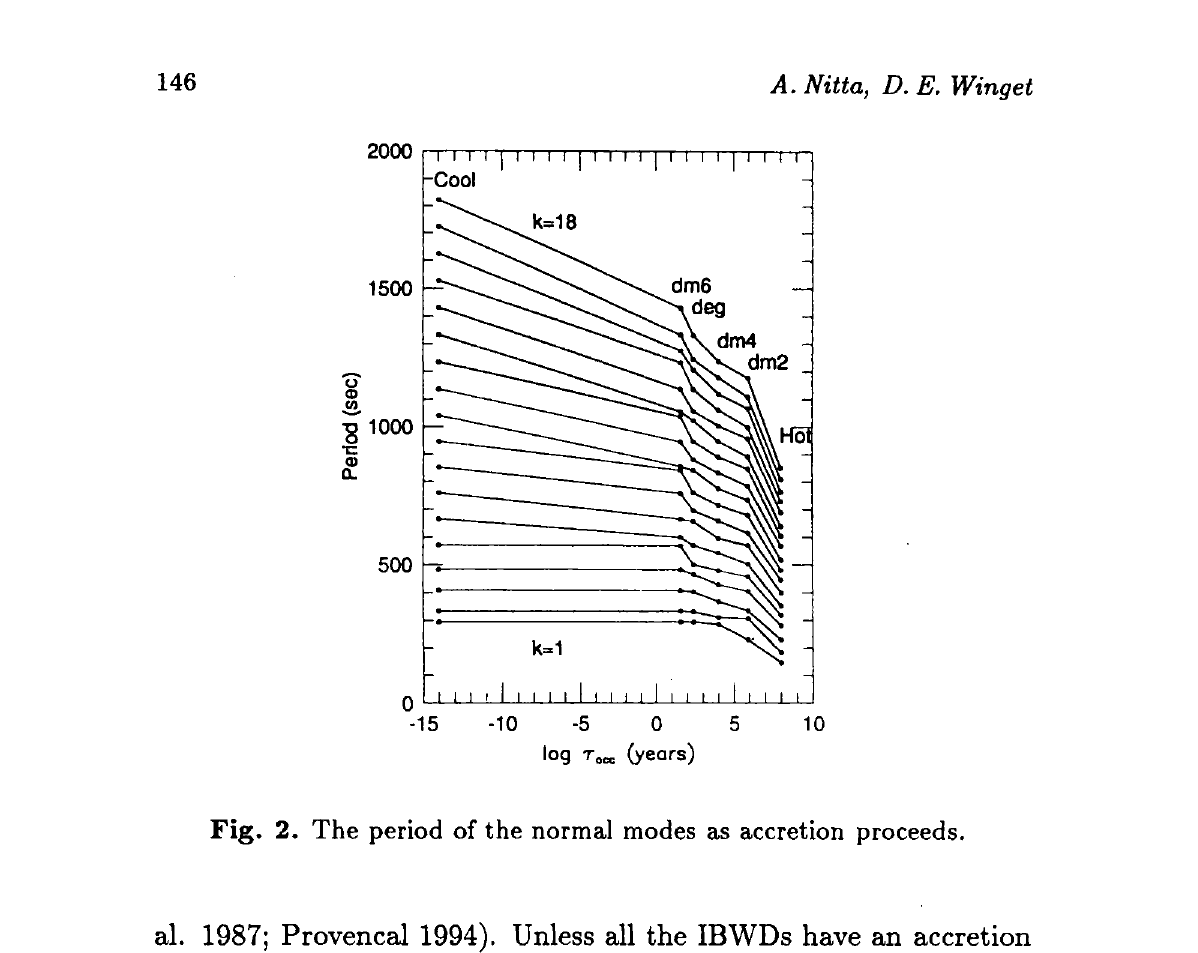
Fig. 2. The period of the normal modes as accretion